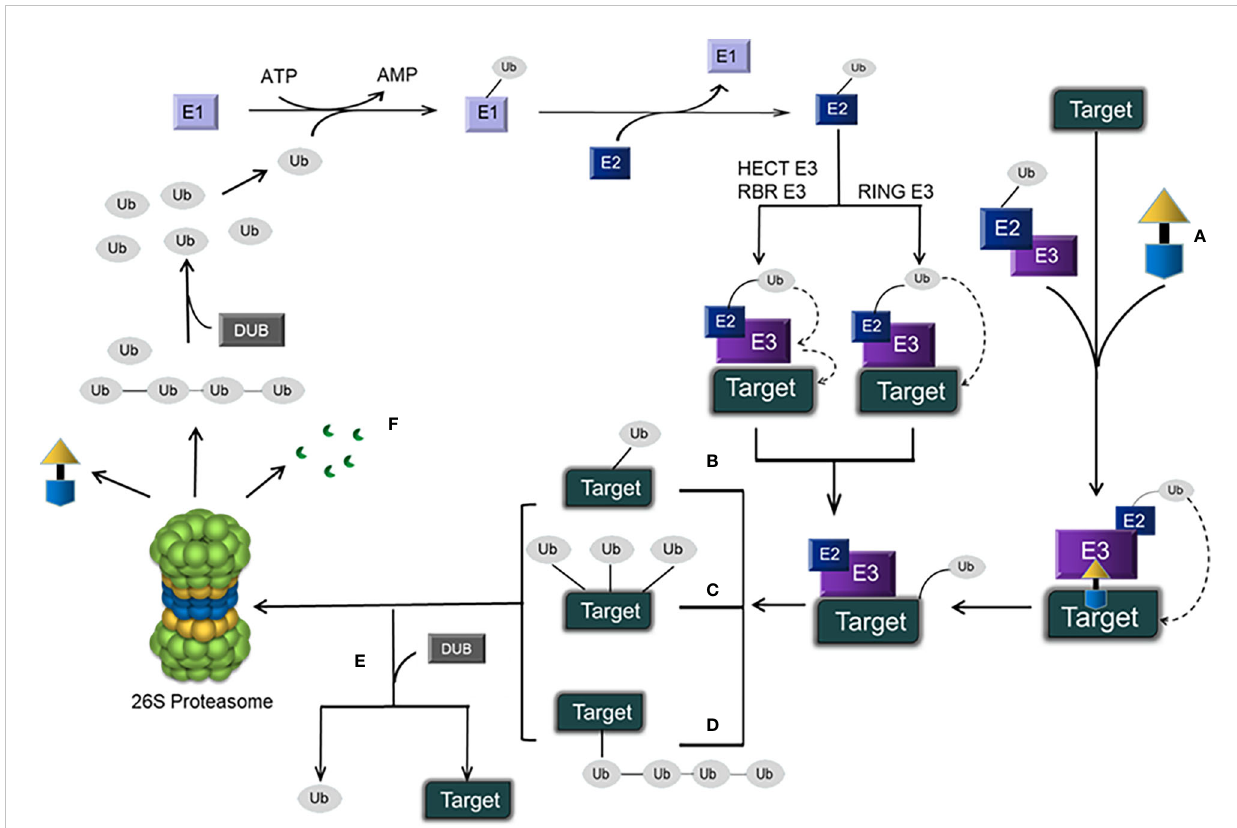
FIGURE 1 Schematic representation of the ubiquitin – proteasome pathway and PROTACs. (A) A PROTAC, which has an E3 ligase ligand at one end and a protein ligand at the other end, is connected by a linker in the middle to form a ternary complex: target protein – PROTAC – E3. Eventually, the target protein is degraded by the 26S proteasome, and the PROTAC is retained. (B) Monoubiquitination. (C) Multiubiquitination. (D) Polyubiquitination. (E) DUB-mediated deubiquitination (which disconnects target proteins from Ub). (F) Protein degradation